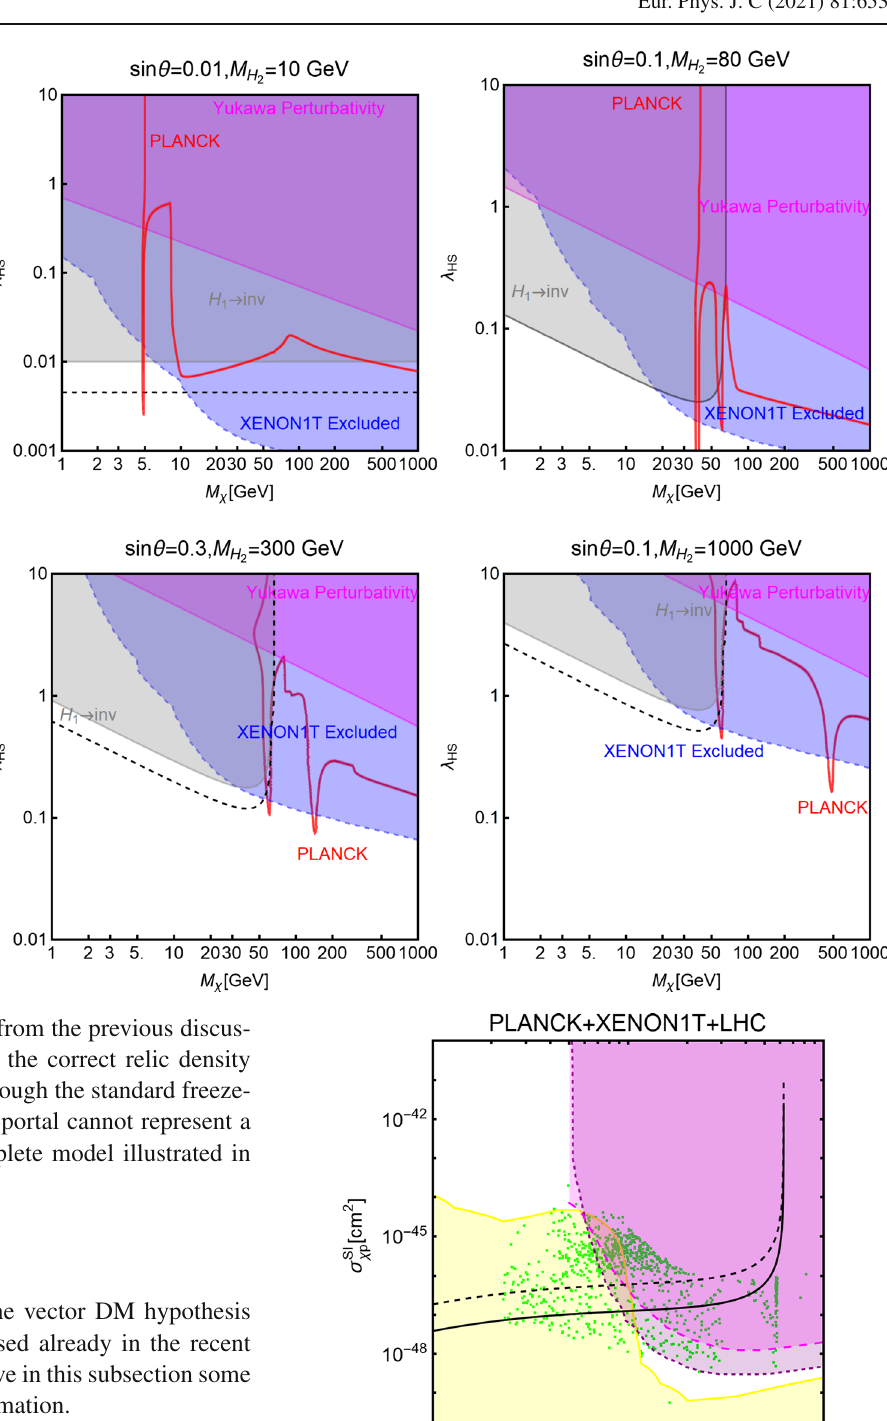
Fig. 10 The same as Fig. 7 but for fermionic